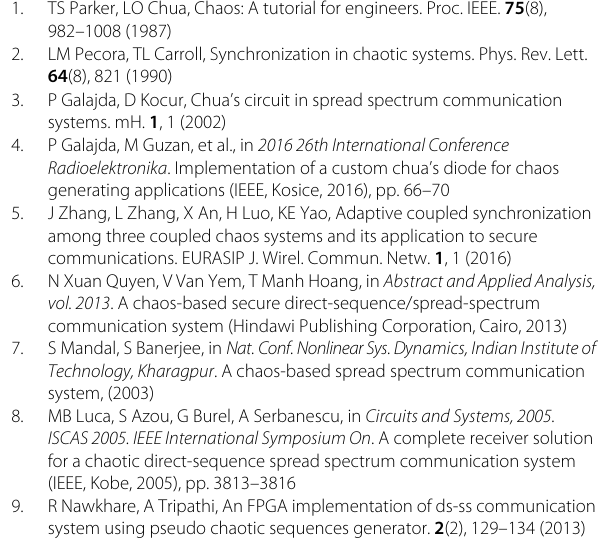
systems. From results of the statistical and correlation properties testing with real-world performance evalua- tion chaotic sequences with desired properties can be